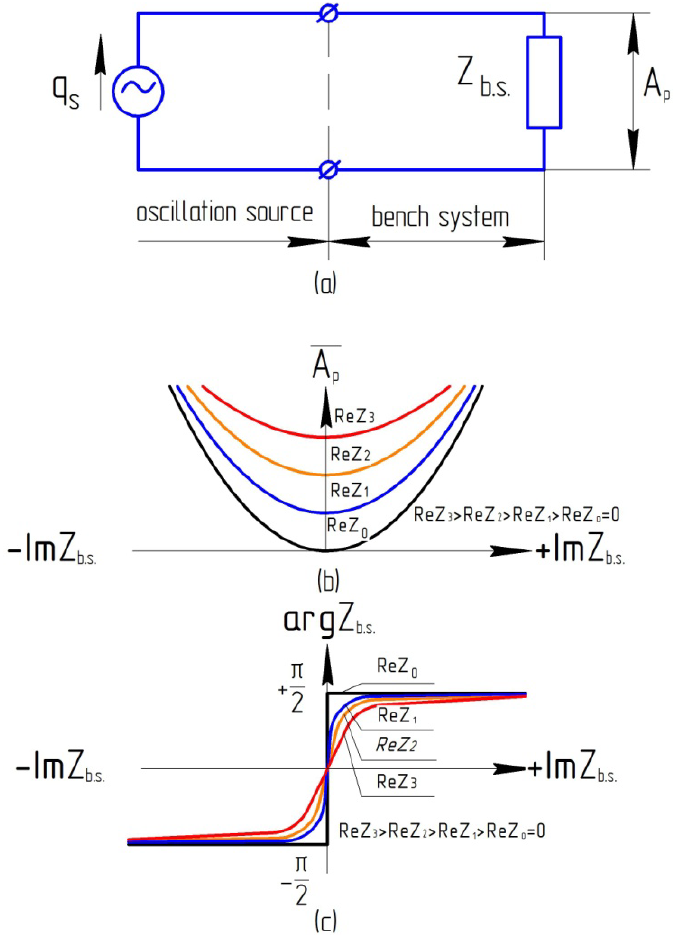
Figure 6. Dependence of the ( b ) amplitude and ( c ) phase of oscillations excited in the ( a ) hydraulic system on the connected system characteristics. ReZ i —active resistance of bench